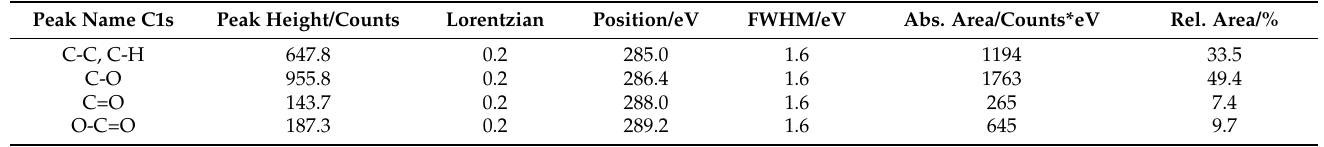
Table 4. Fit parameters of the C1s of JRCNM62002a.